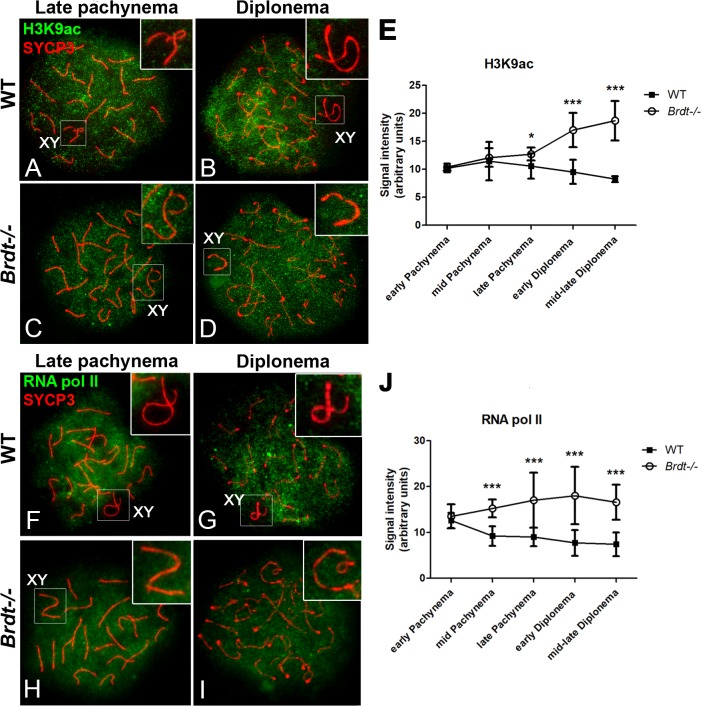
Depletion of BRDT disrupts the timing of removal of transcriptional activation markers in the X and Y chromosomes.(A-D, F-I) Chromosome spreads of wild type (WT) and Brdt-/- late pachytene and diplotene spermatocytes. Insets show an enlargement of the sex chromosomes. (A-D) Immunolocalization of H3K9ac (green) and SYCP3 (red). (A-B) In WT late pachytene and diplotene spermatocytes, H3K9ac localizes in the chromatin of autosomal chromosomes but is absent in the sex chromosomes (XY; inset). (C-D) In Brdt-/- late pachytene and diplotene spermatocytes, H3K9ac signal is intense and localizes in the chromatin of both autosome and sex chromosomes (XY; inset). (E) Quantification of the signal intensity of H3K9ac in the sex body in both WT (black squares) and Brdt-/- (white circles) spermatocytes. *p = 0.05, ***p = 0.001. Samples were obtained from three 3 month-old WT and Brdt-/- mice. n = 10 and 12 early pachytene, 24 and 25 mid pachytene, 30 late pachytene, 20 early and 40 mid/late diplotene WT and Brdt-/- spermatocytes, respectively, per mouse. Error bars indicate standard deviation. (F-I) Immunolocalization of RNA pol II (green) and SYCP3 (red). (F-G) In WT late pachytene and diplotene spermatocytes, RNA pol II localizes throughout the chromatin of autosomes but is barely detected in the sex chromosomes (XY, inset). (H, I) In Brdt-/- spermatocytes, RNA pol II is present in the chromatin of both autosomes and sex chromosomes. (J) Quantification of the signal intensity of RNA pol II in the sex chromosomes in both WT (black squares) and Brdt-/- (white circles) spermatocytes. ***p = 0.001. Samples were obtained from three 3 month-old WT and Brdt-/- mice. n = 15 early pachytene, 25 mid pachytene, 40 late pachynema, 25 early and 35 mid/late diplotene WT and Brdt-/- spermatocytes, respectively per mouse. Error bars indicate standard deviation.